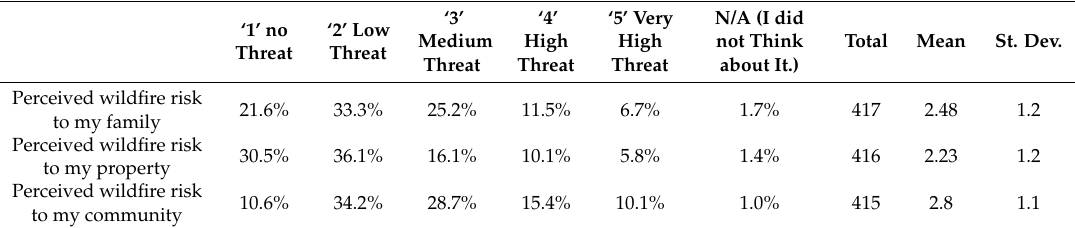
Table 2. Survey participants’ rating of the wildfire threat a few days before the evacuation on a scale from ‘1’ no threat to ‘5’ very high threat (n = 418). ‘3’ ‘1’ no ‘2’ Low Medium St. Threat Threat